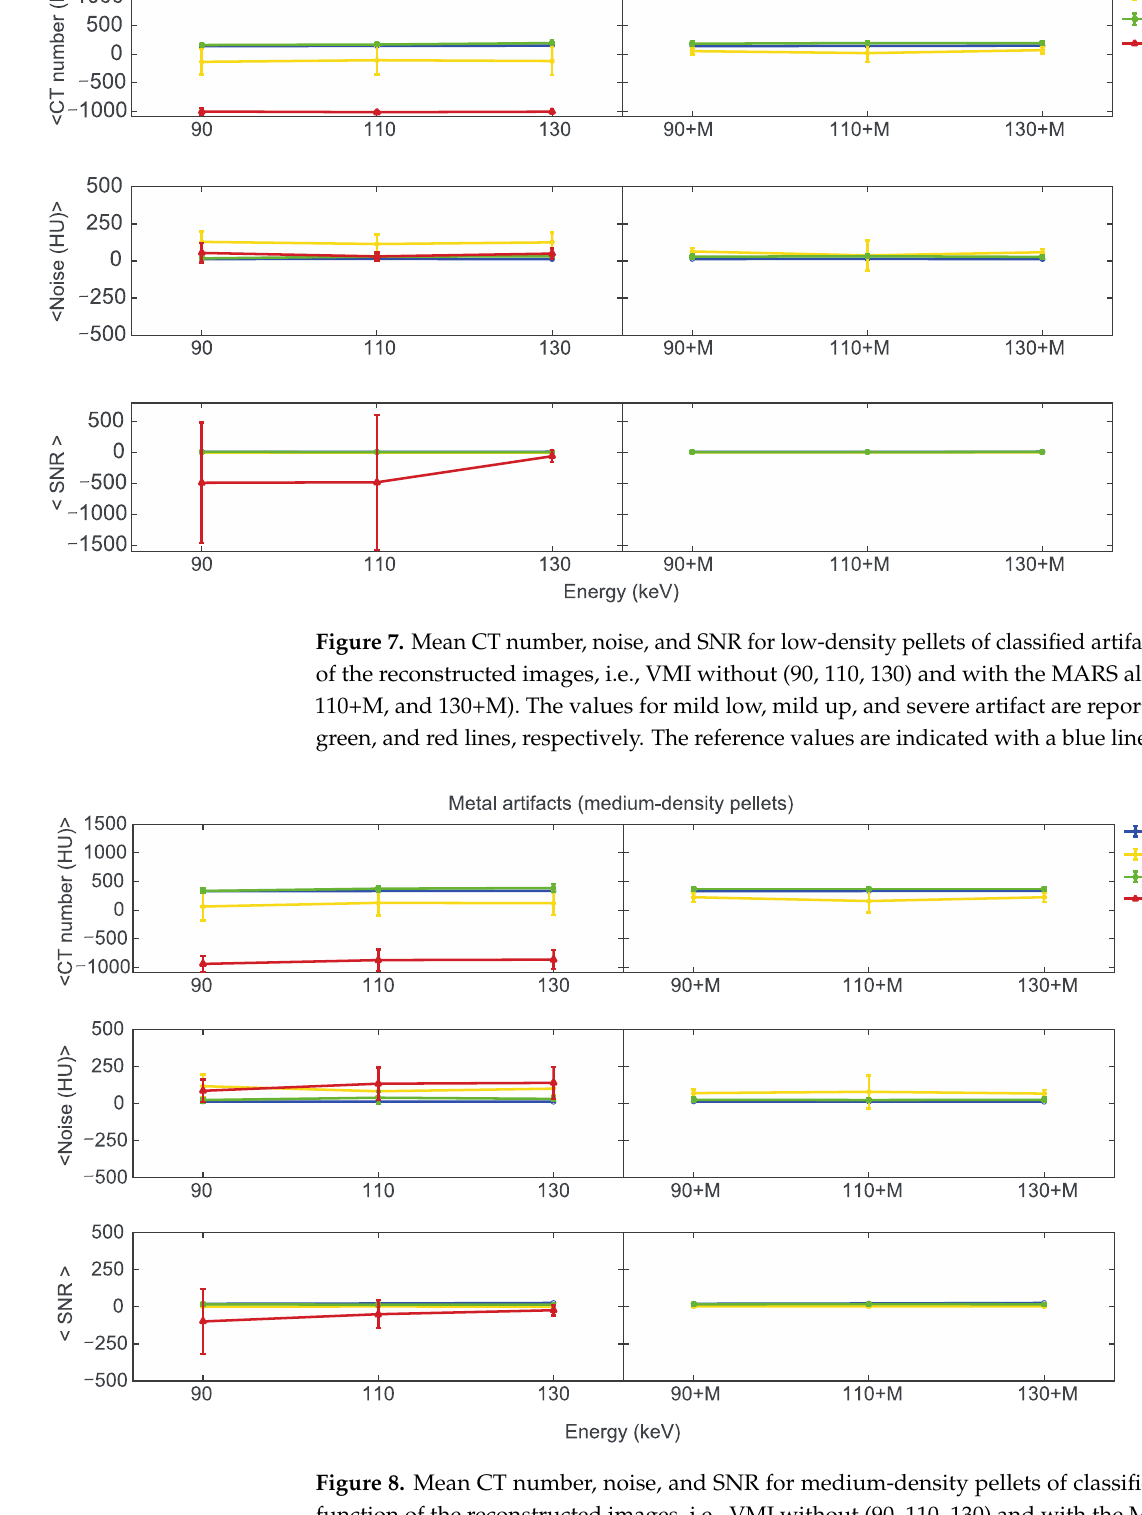
Figure 9. Mean CT number, noise, and SNR for high ‐ density pellets of classified artifacts as a func ‐ tion of the reconstructed images, i.e., VMI without (90, 110, and 130) and with the MARS algo ‐ rithm (90+M, 110+M, and 130+M). The values for mild low, mild up, and severe artifact are re ‐ ported with yellow, green, and red lines, respectively. The reference values are indicated with a blue line. We found positions strongly affected by the presence of metal artifacts, such as those related to the low ‐ density b3 pellets in CO+TI and CO+SS bilateral configurations. In some